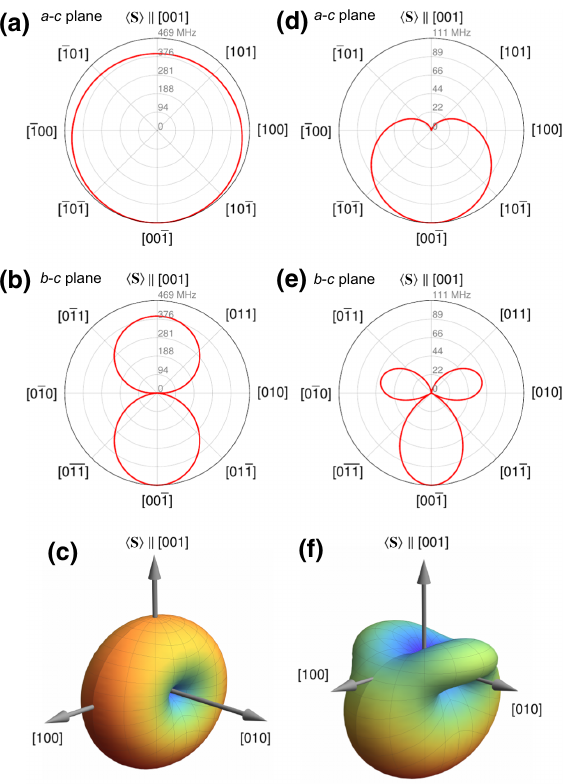
FIG. 2. Evolution of the magnetoelectric magnon-photon cou- pling | g | / 2 π in the ferromagnetic phase of Cu 2 OSeO 3 upon rotation of the spin moment (cid:7) S (cid:8) in (a),(d) the a - c plane, (b),(e) the b - c plane, and (c),(f) a general direction. Note in particular the asymmetry with respect to magnetization reversal, | (cid:2) g ( (cid:7) S (cid:8) ) | (cid:6)= | (cid:2) g ( −(cid:7) S (cid:8) ) | . Cavity field directions read E (cid:9) [100] and B (cid:9) [010]. Field amplitudes are chosen as (a)–(c) E = E 0 / √ B = B / 2 and (d)–(f) E = 0.996 E 0 and B = 0.091 B 0 0